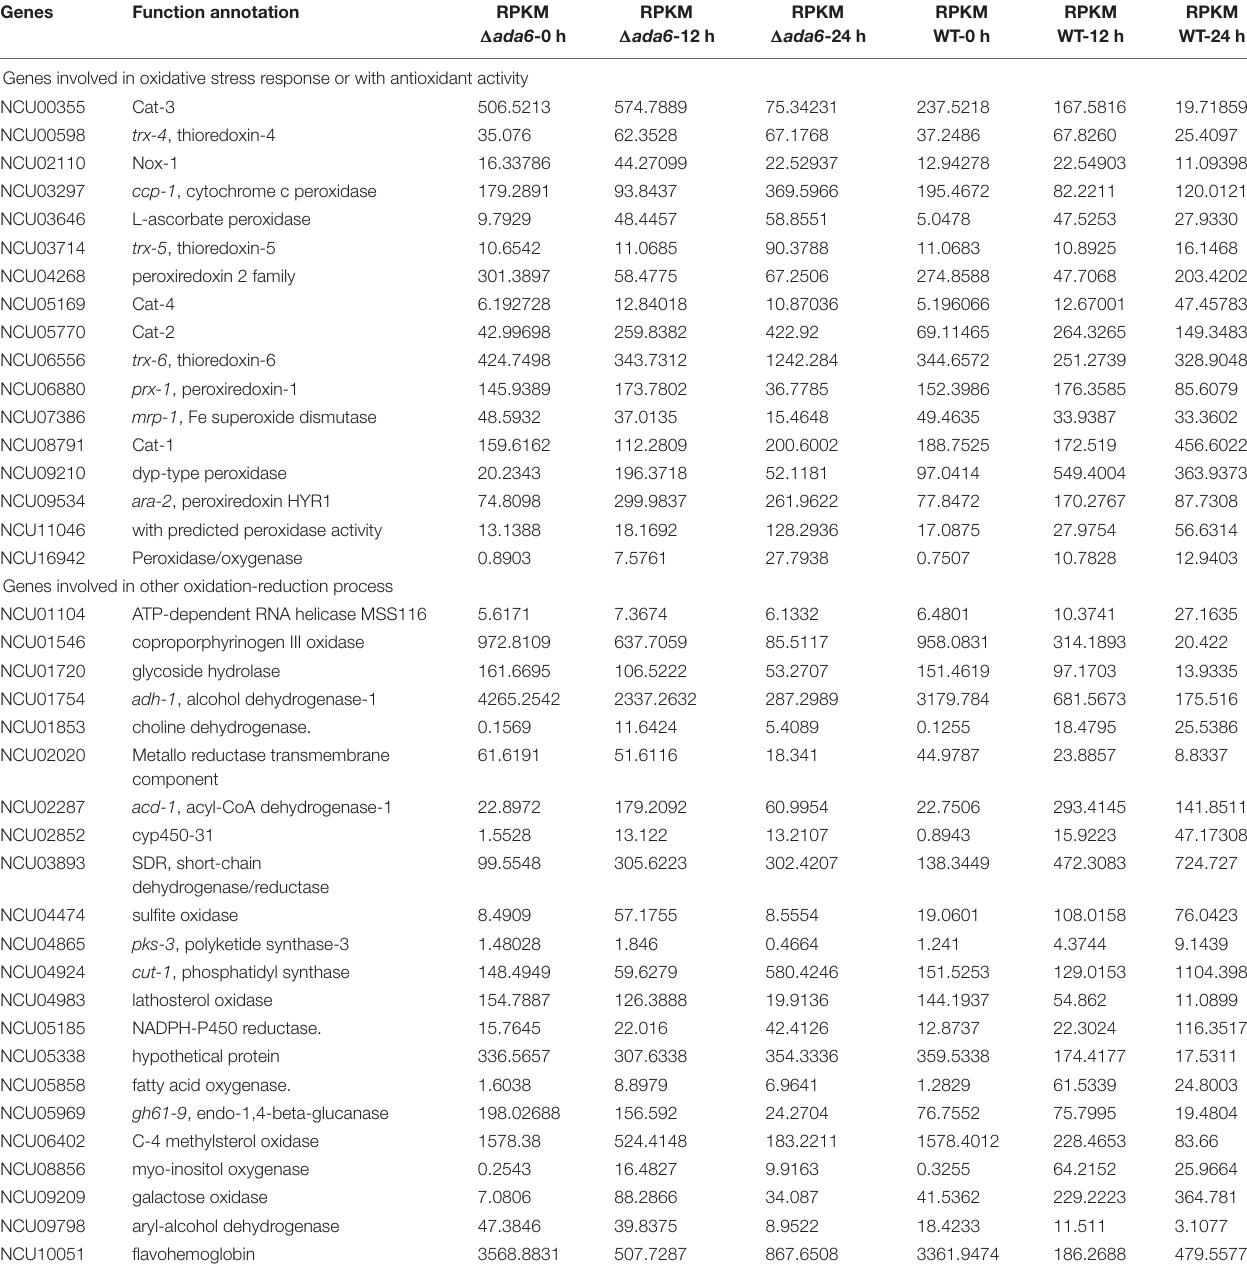
TABLE 2 | Transcriptional responses to ada-6 deletion by the genes involved in oxidation-reduction process. Genes Function